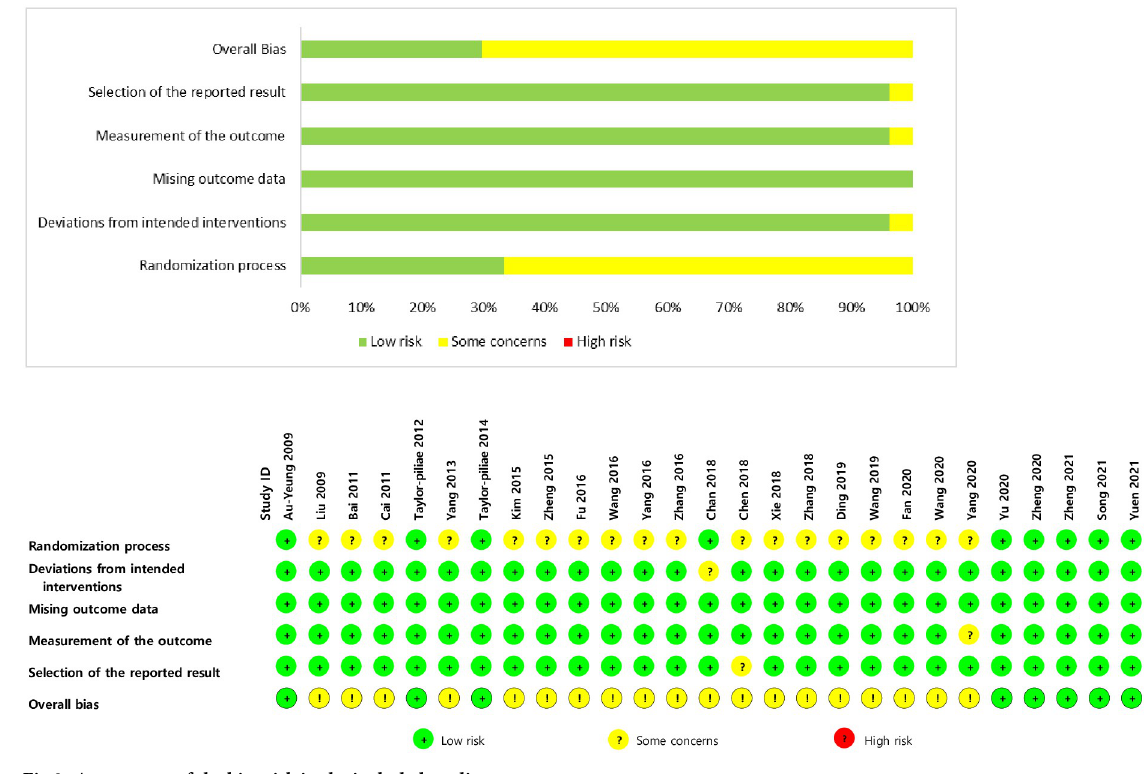
Fig 2. Assessment of the bias risk in the included